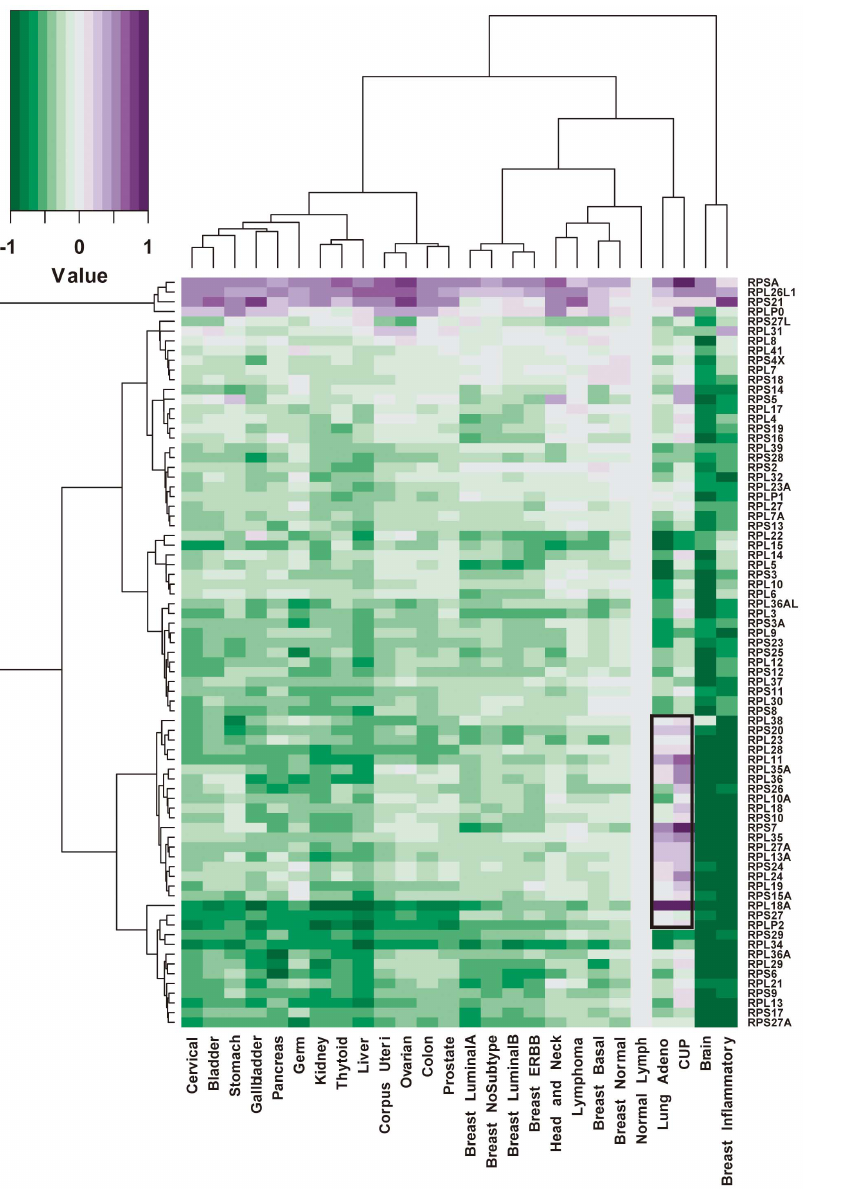
Figure 3. Heatmap representing the expression of 77 ribosomal protein genes in CUP, normal lymph nodes, and other cancer types. Ribosomal protein genes are indicated on the right. On the heatmap, purple represents up-regulated genes and green represents down- regulated genes, relative to the expression levels in normal lymph nodes, with the scale shown in the upper left. The genes that were exclusively overexpressed in CUP and lung adenocarcinoma are highlighted.